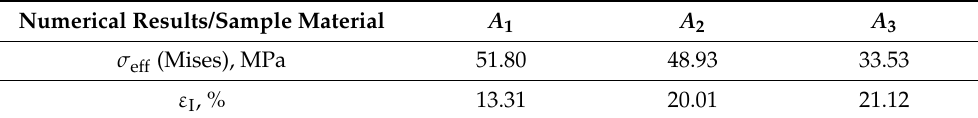
Table 4. Maximum values of selected parameters determined by conducting numerical calculations.